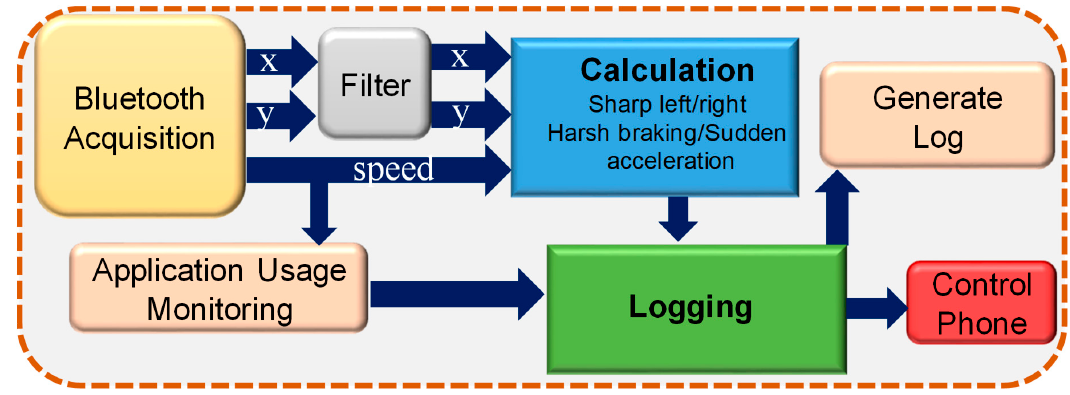
Figure 5. Block diagram to show the stages of the application’s operation.